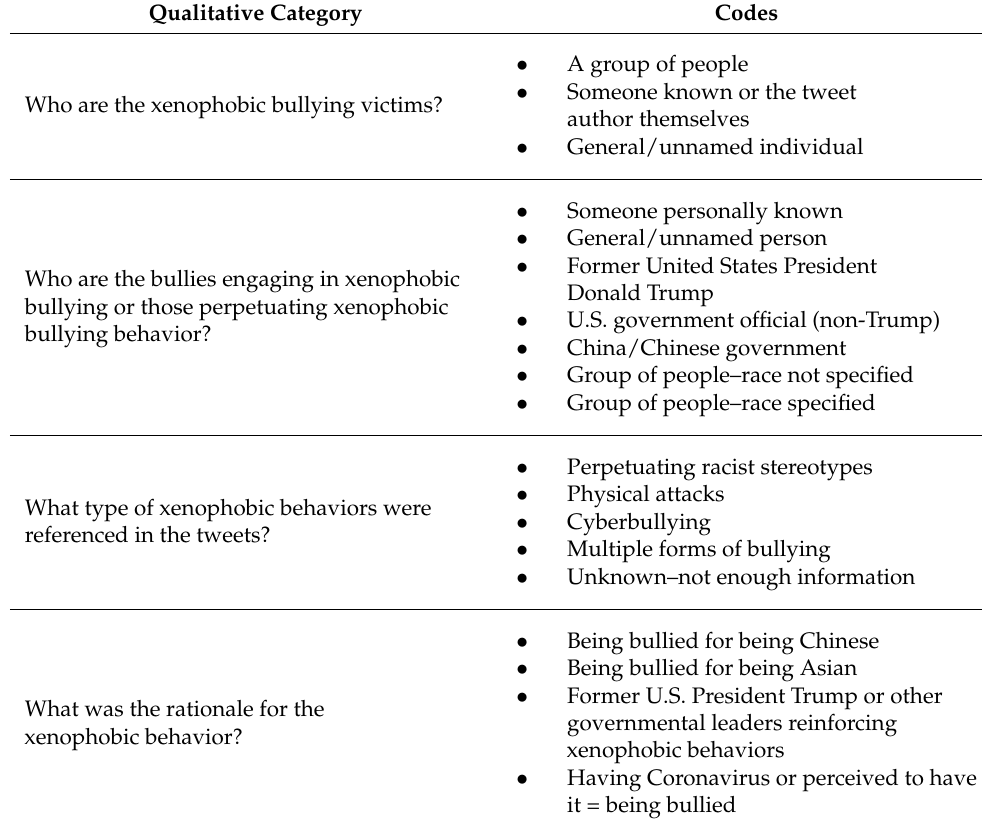
Table 2. Qualitative categories and